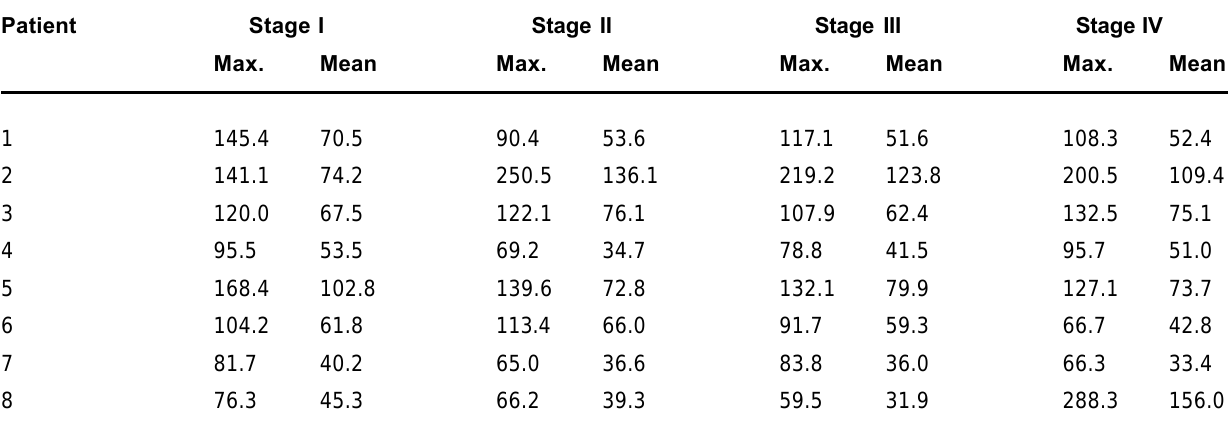
TABLE 5 - Maximum and mean mandibular speed during closure movement (in millimeters per Patient